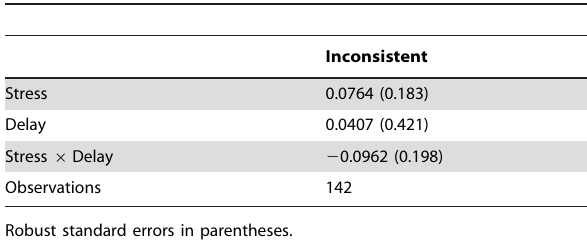
Table 9. Effect of stress on inconsistent responses in time preference